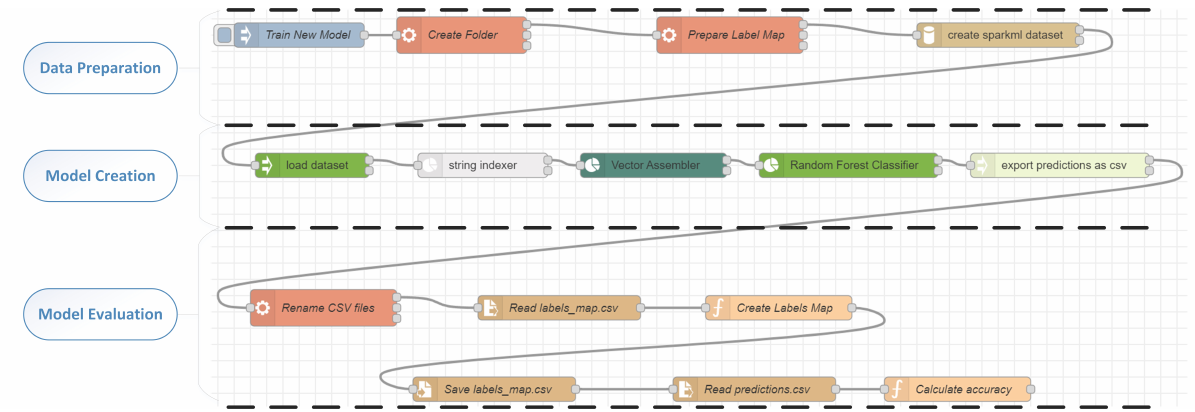
Figure 3. Model trainer component internal processes